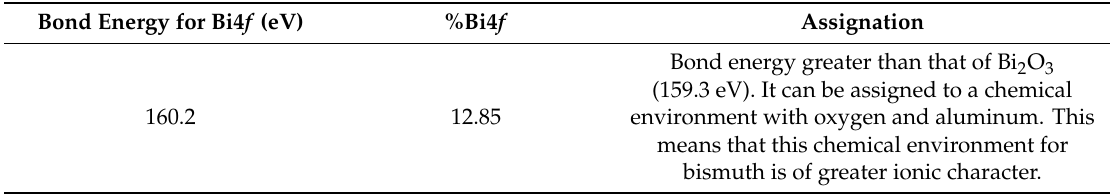
Table 6. Atomic concentrations and assignments for the Bi4 f region for the compound Bi 2 O 2 CO 3 :Al. Bond Energy for Bi4 f (eV) %Bi4 f Assignation Bond energy greater than that of Bi 2 O 3 (159.3 eV). It can be assigned to a chemical 160.2 12.85 environment with oxygen and aluminum. This means that this chemical environment for bismuth is of greater ionic character.